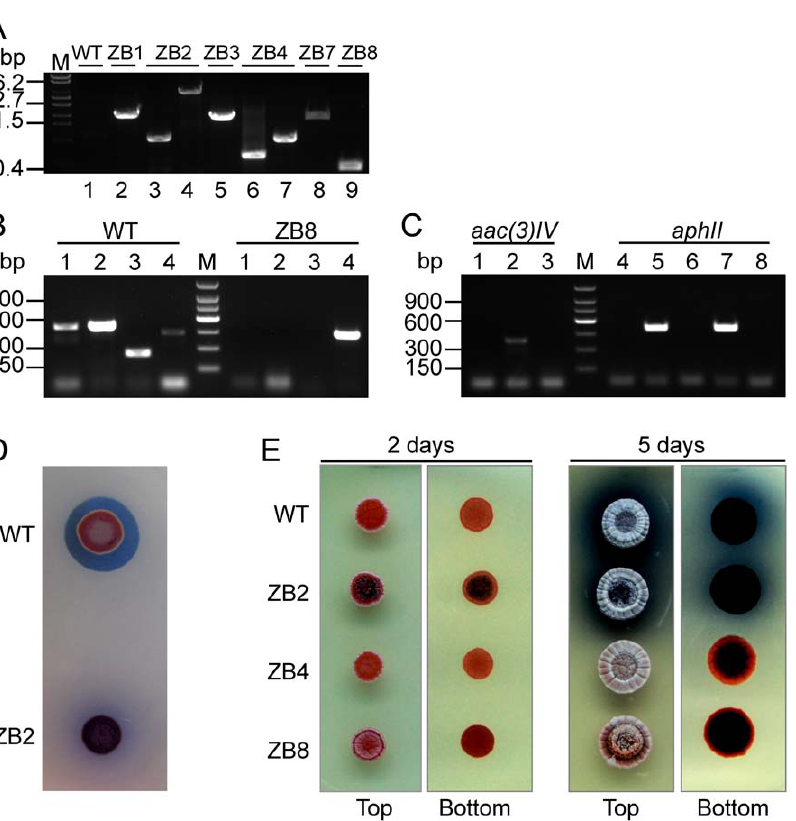
Figure 3. PCR analysis and phenotypes of mutants. (A) PCR verification of gene deletion. Lane 1, a 42,725 bp fragment was amplified using primers ZB287/ZB288. The size of the fragment was too large and could not be PCR-amplified, thus no band was seen in lane 1. Lane 2, a 1981 bp fragment was amplified using primers ZB287/ZB288. The CDA biosynthetic gene cluster was replaced with the aac(3)IV gene. Lane3, a 927 bp fragment was amplified using primers ZB287/ZB288, and the resistance gene was removed. Lane 4, a 4073 bp fragment was amplified with primers ZB289/ZB290. Lanes 5 and 6 showed the bands before and after removing the aphII resistance gene. Lane 7, a 928 bp fragment was amplified with primers ZB285/ZB286. Lanes 8 and 9 showed thebands before and after removing the aphII resistance gene. WT, wild type strain; ZB1 , ZB8, serial mutant strains. (B) PCR verification of gene deletion. Lane 1: the fragment was amplified with primers ZB145/ZB146 and primers were both within sco3229 . Lane 2: the fragment was amplified with primers ZB195/ZB196 and primerZB195 was within sco5089 and primer ZB196 was within sco5090 . Lane 3: the fragment was amplified with primers ZB184/ZB186 and primerZB184 was within sco1103 and primer ZB184 was within sco1104 . Lane 4: the fragment as a positive control was amplified with primers ZB147/ZB148 and primers were both within sco5888 . M: 150 bp ladder. (C) PCR verification of the resistance removing. Lane 1: M145; Lane 2: ZB1; Lane 3: ZB2. The three fragments were amplified with primers ZB189/ZB190, primers were both within the acc(3)IV gene. Lane 4: M 145; Lane 5: ZB3; Lane 6: ZB4; Lane 7: ZB7; Lane 8: ZB8. The five fragments were amplified with primers ZB187/ZB188, primers were both within the aphII gene. M: 150 bp ladder. (D) Bioassay of CDA extracts from the WT strain and CDA-null mutant strain ZB2. (E) Phenotypes of wild-type and three mutant strains. The spores were cultured for 2 days (left) and 5 days (right) on R2YE agar.